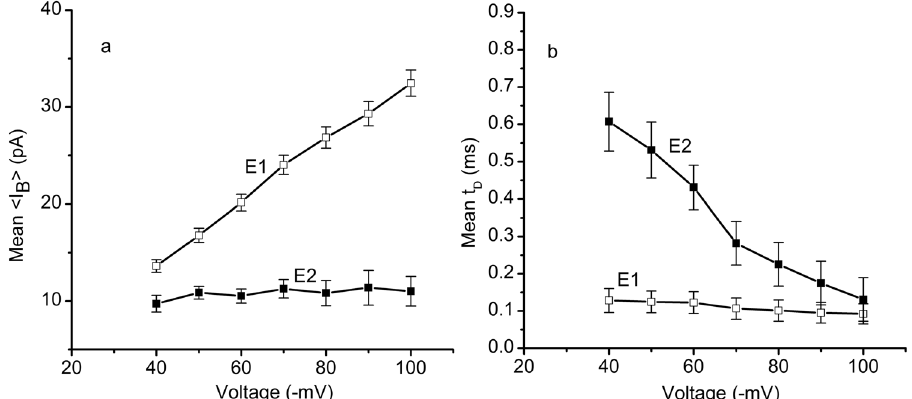
Figure 3. Voltage dependency of the interactions between single lysenin channels and Ang II. ( a ) The mean < I B > of events E1 (open squares) followed the applied voltage in a linear manner, as expected for translocations. In contrast, the applied voltage had a much smaller influence on the current blockages characterizing the E2 events (full squares). ( b ) The mean t D of the transient blockages decreased with the applied voltage for both E1 (open squares) and E2 (full squares) events. The data in both panels are represented as mean ± s.d, n = 3; each sample size consisted of at least 2800 events.